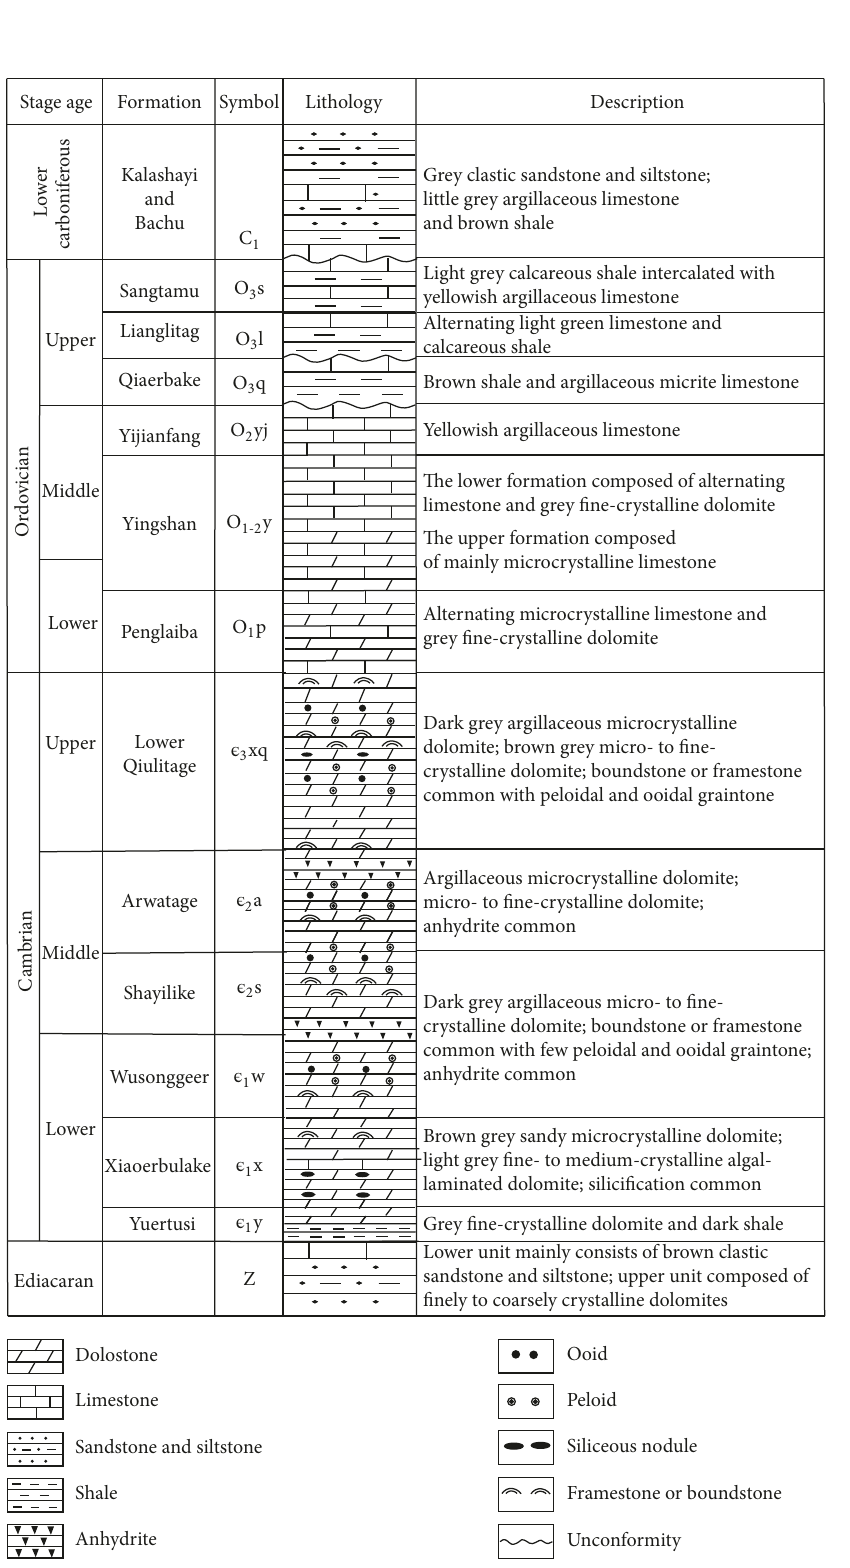
Figure 2: Generalized stratigraphic column from the Cambrian to Lower Carboniferous successions in the northern Tarim Basin, based on data from [5,